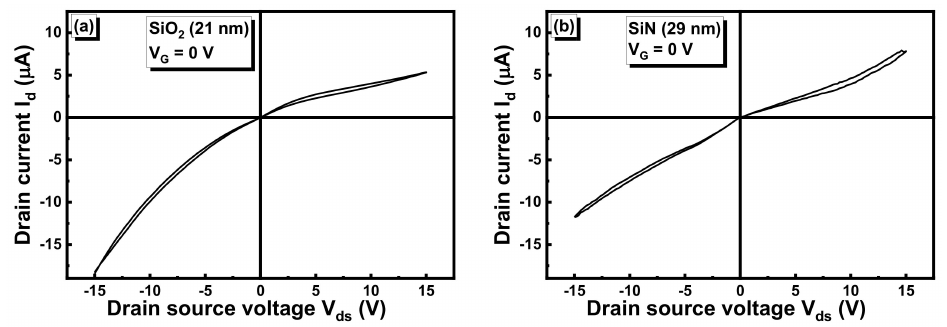
Figure 5. I d -V ds sweeps of ( a ) MoSe 2 /SiO 2 /Si and ( b ) MoSe 2 /SiN/Si MISFET devices.